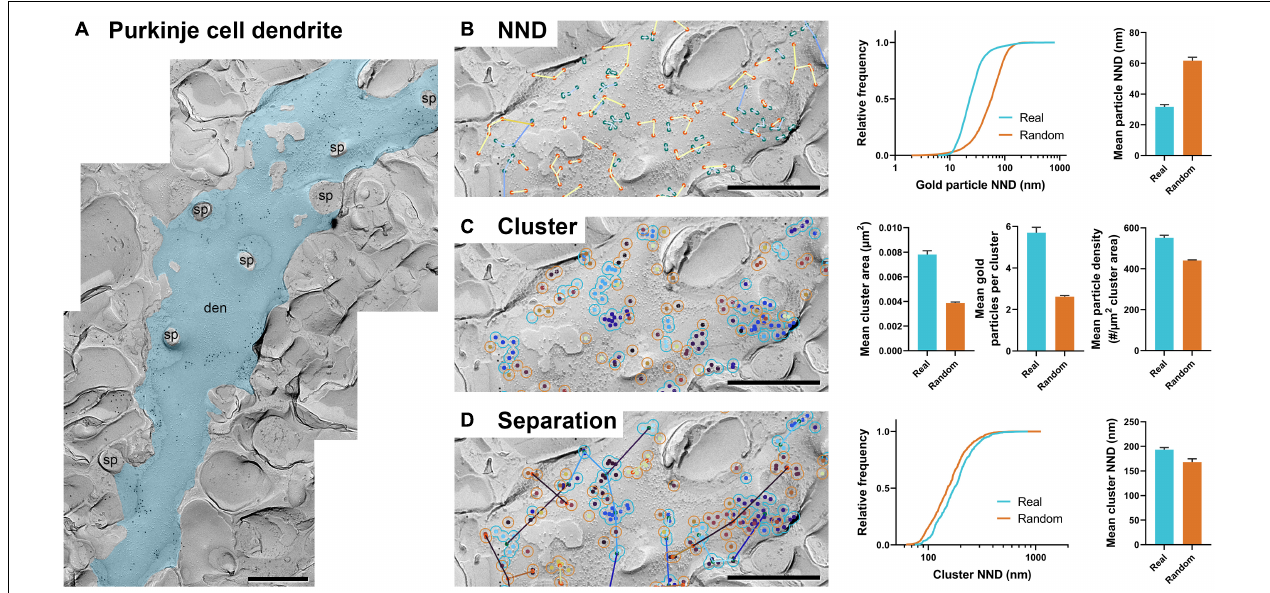
FIGURE 5 | GIO can be applied to replica images of dendrites. (A) An image of a portion of Purkinje cell dendrite with 12 nm gold particles labeling Cav2.1. The dendrite ROI is shown as a blue overlay. sp = spine, den = dendrite. (B) GIO output for particle NND analysis of real and random distributions including a comparison of cumulative frequencies and mean particle NNDs. (C) GIO output for cluster analysis of real and random particle distributions, including grand mean cluster area, number of gold particles per cluster, and gold particle density within clusters. (D) GIO output for separation analysis of clusters of real and random particle distributions, including a comparison of cumulative frequencies and grand mean cluster NND. Error bars represent S.E.M. n = 11 ROIs. Scale bars: 500